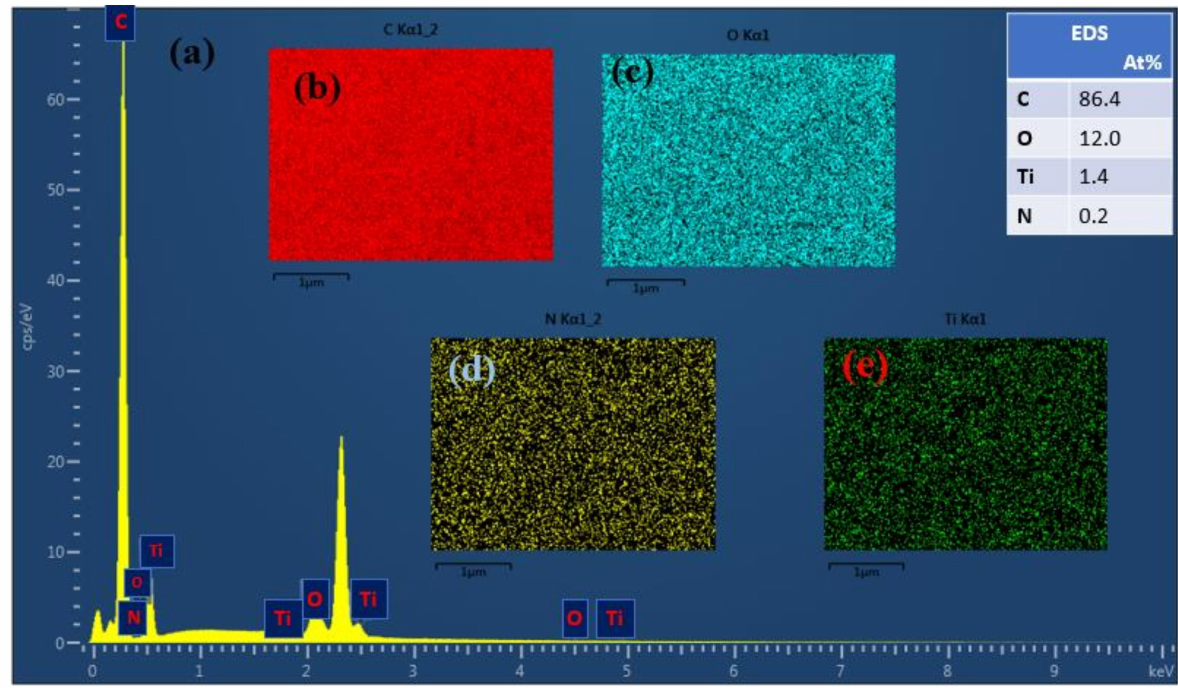
Figure 5. ( a ) Energy spectrum analysis results of the NF_PAN_Ti and the sample table surface elements containing ( b ) carbon, ( c ) oxygen, ( d ) nitrogen, and ( e )